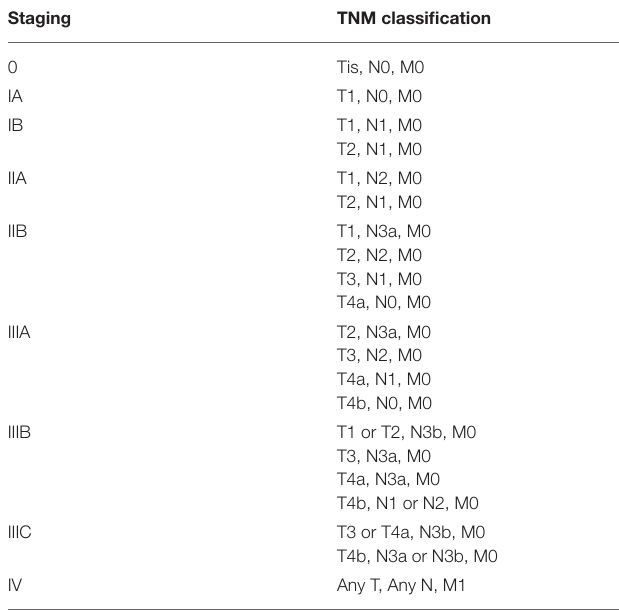
TABLE 1 | Shows classification of TNM staging system used for cancer diagnosis.